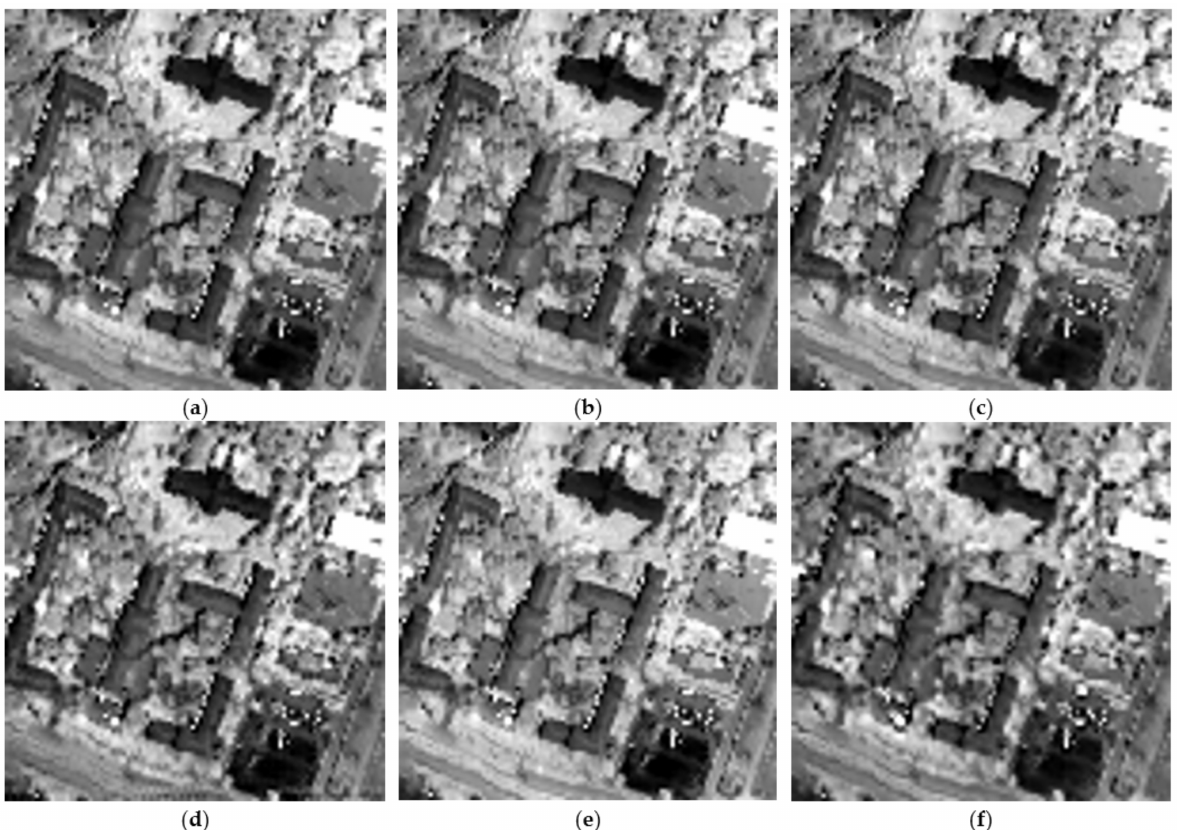
Figure 6. Spectral band in the 0.850 µ m region ( a ) Original hyperspectral image; ( b ) Obtained HSB- SV sharpened hyperspectral image; ( c ) Obtained HMF-IPNMF sharpened hyperspectral image; ( d ) Obtained HySure sharpened hyperspectral image; ( e ) Obtained CNMF sharpened hyperspectral image; ( f ) Obtained FuVar sharpened hyperspectral image.